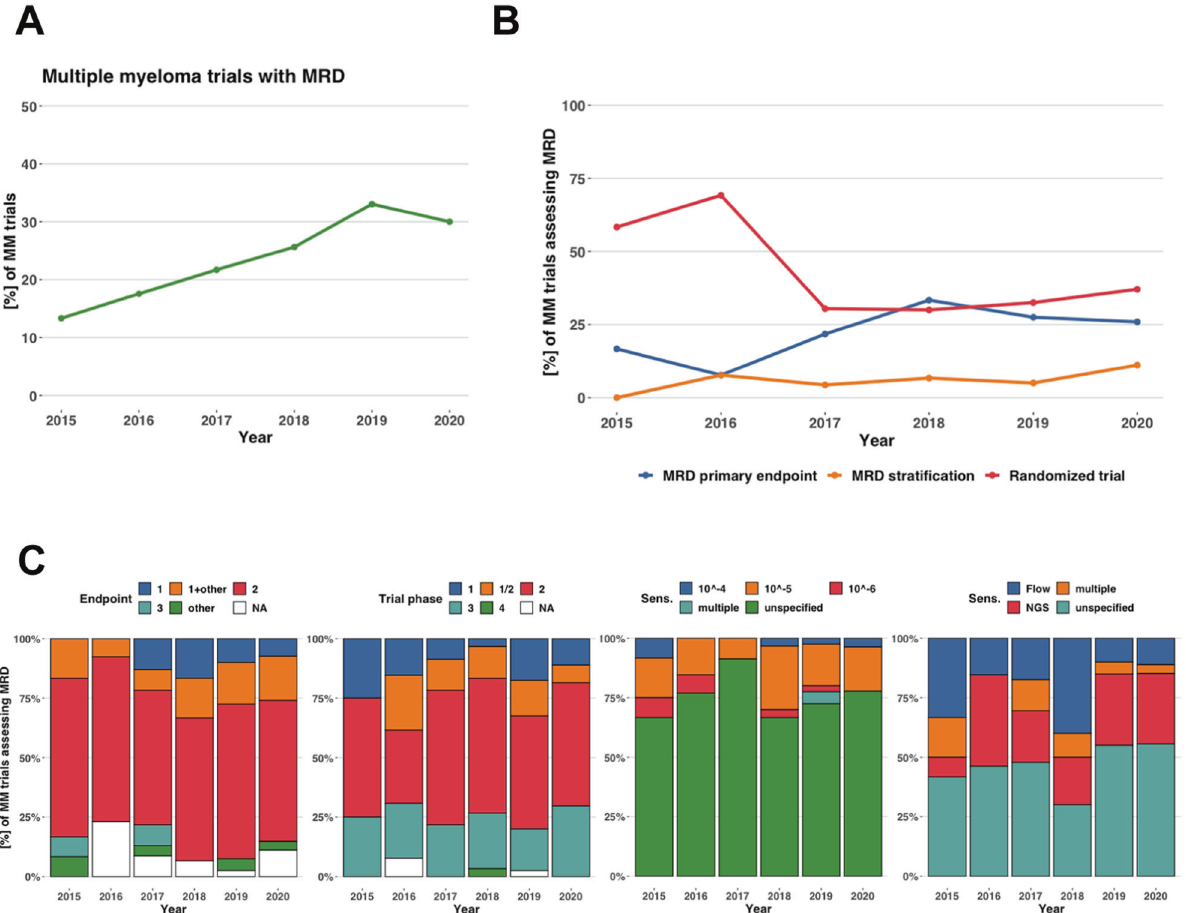
Fig. 1 Percentage of multiple myeloma clinical trials with measurable residual disease (MRD) and their characteristics over time as reported within ClinicalTrials.gov. A Percentage of all clinical trials for multiple myeloma (MM) that included MRD assessment split by year of clinical trial start date. B Within MM trials assessing MRD, the percentage of trials that include MRD as a part of the primary endpoint (blue), that include strati fi cation based on MRD (orange) and that are randomized (red) and the change over time. C Within MM trials assessing MRD, distribution of endpoint, trial phase, MRD sensitivity and MRD measurement method and the change over